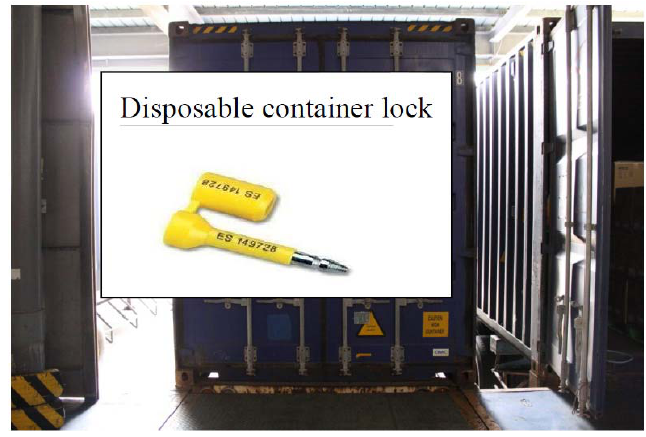
Figure 5. Photograph of disposable container